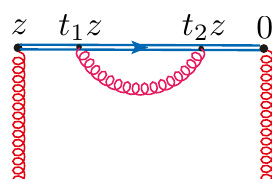
Figure 1 . Self-energy-type correction for the gauge